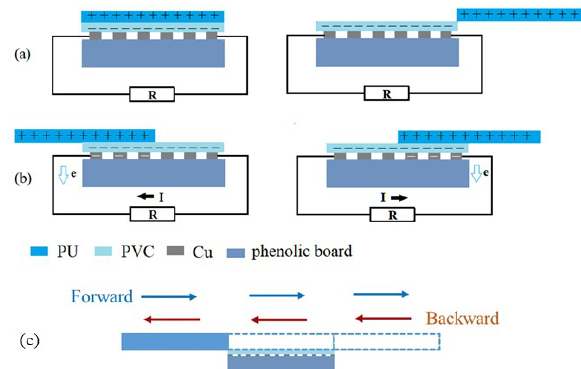
Figure 2. Mechanism of charge distribution and electricity generation by the spiral electrode TENG. a) no-current in full-overlapped and non-overlapped cycles, b) current direction in forward and backward sliding, c) schema for a complete motion.